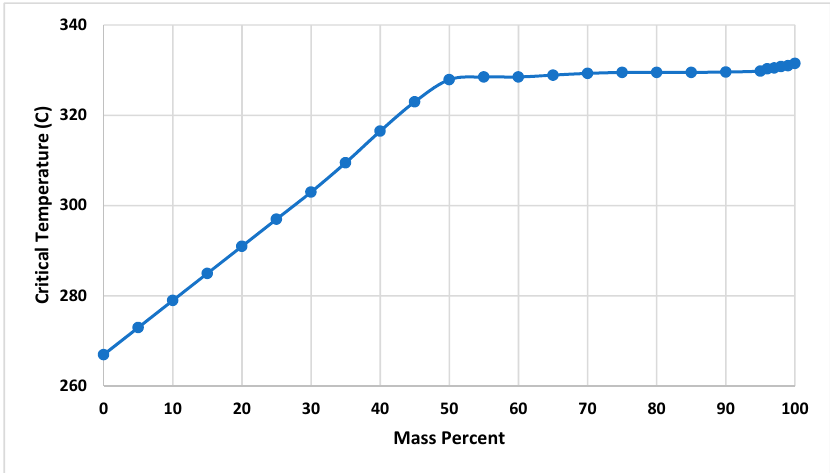
Figure 4. Plot of the critical temperature against the mass percentage of the